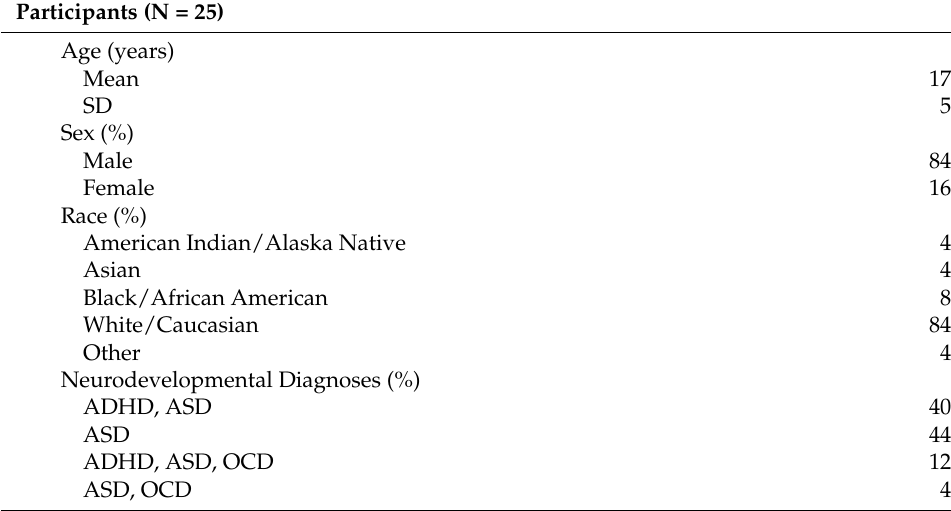
Table 1. Participant